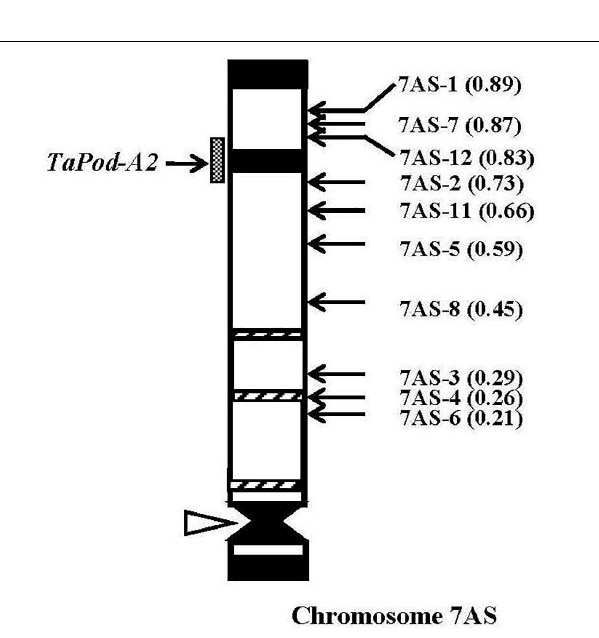
FIGURE 5 | Physical map of Chinese Spring (CS) chromosome 7AS. The identification of deletion lines and fraction arm length (FL) values of breakpoints ( parentheses ) is shown on the right . C-banding patterns of chromosomes are taken from Gill et al. (1991). The chromosomal region ( gray hatched bar ) from FL = 0.73 to FL = 0.83 indicates the putative location of the TaPod-A2 gene. Chromosome short arms point toward the top and the open arrow ( left ) shows the position of the